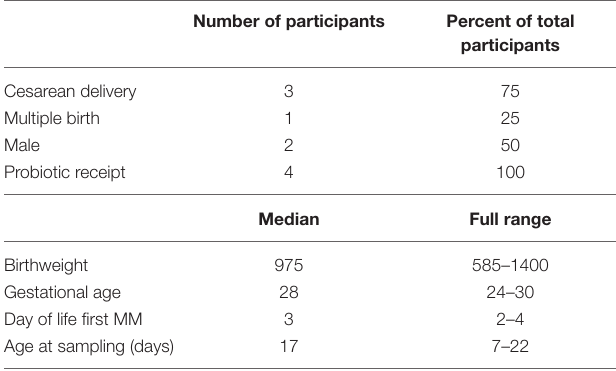
TABLE 1 | Recorded characteristics of clinical cohort used in pilot study.